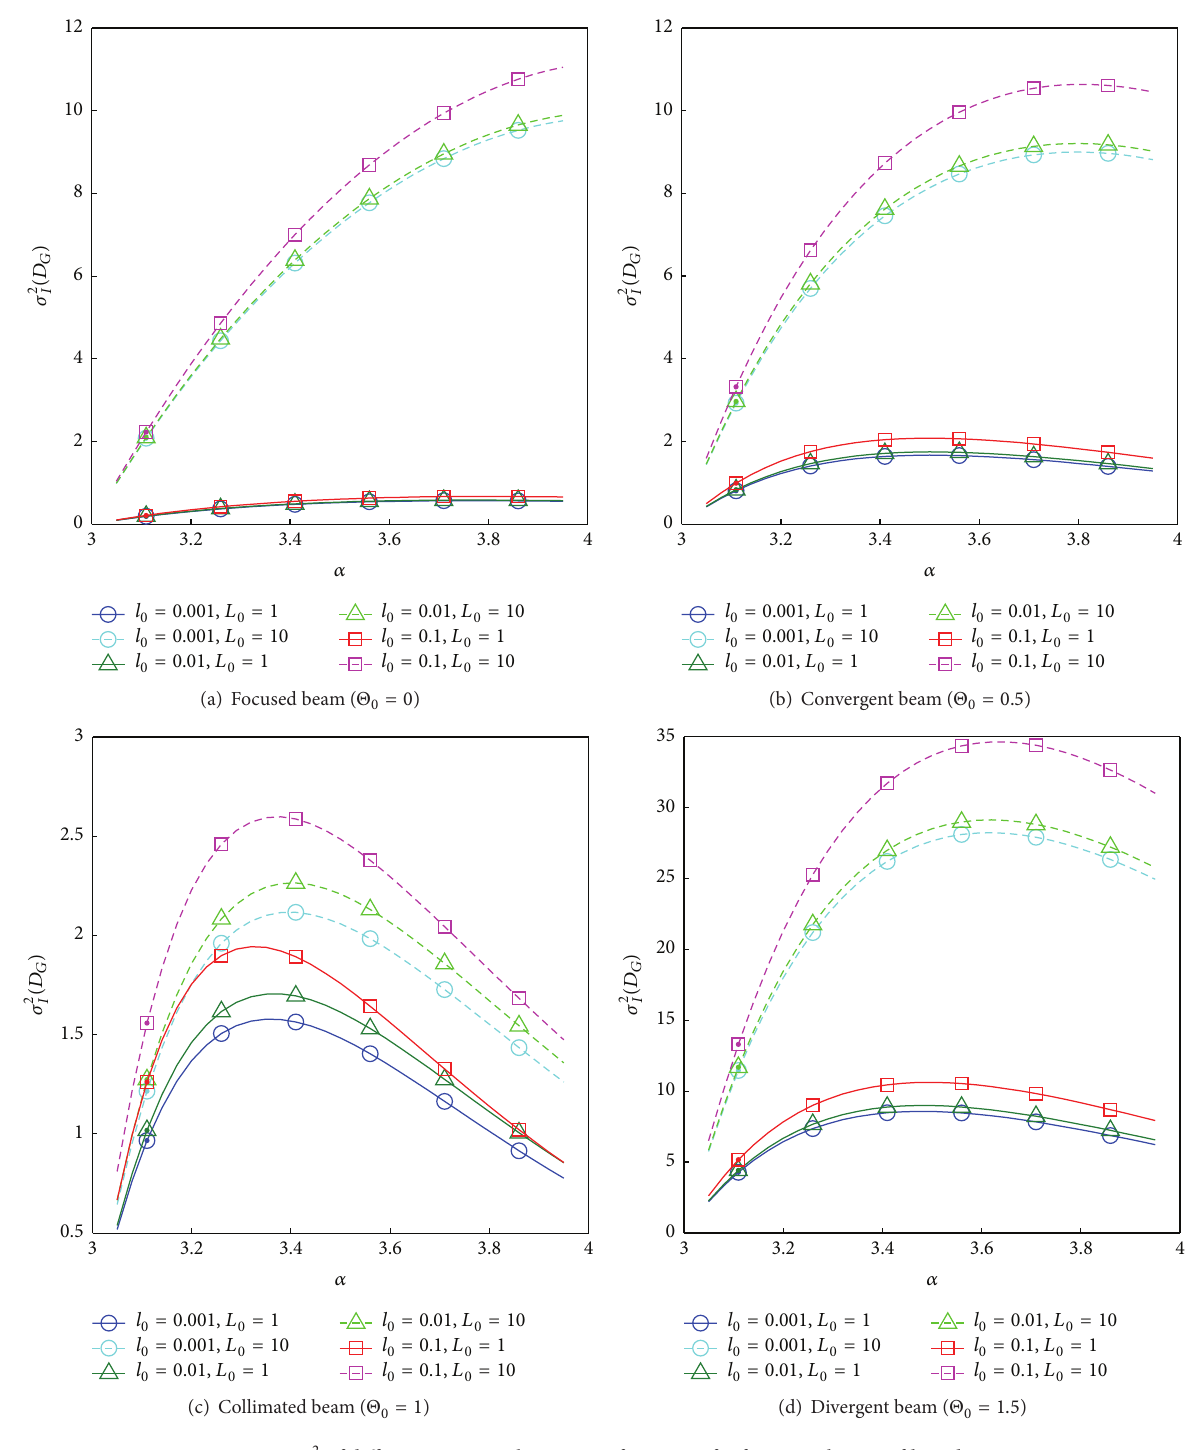
Figure 1: 𝜎 2 𝐼 of different Gaussian beams as a function of 𝛼 for several pairs of 𝑙 0 and 𝐿 0